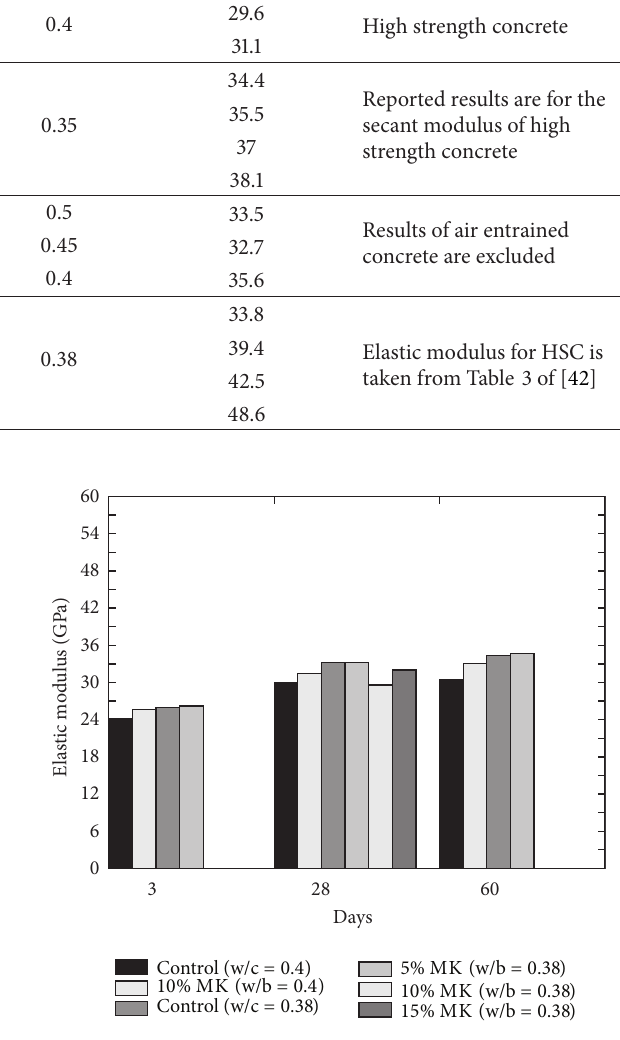
Figure 21: Effect of cement replacement on the elastic modulus of MK concrete [30,